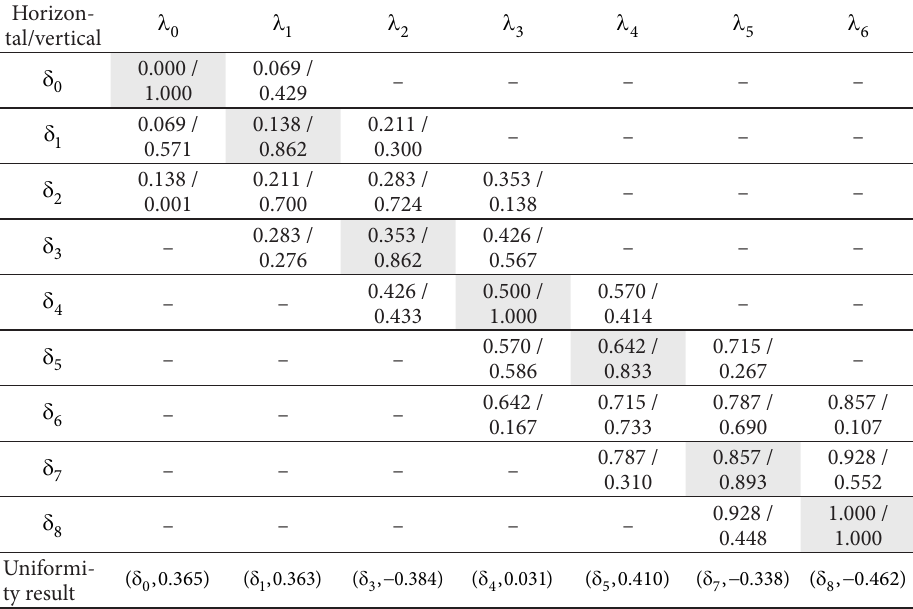
Table 5. Linguistic scale uniformity matrix for linguistic variable l and d Horizon-